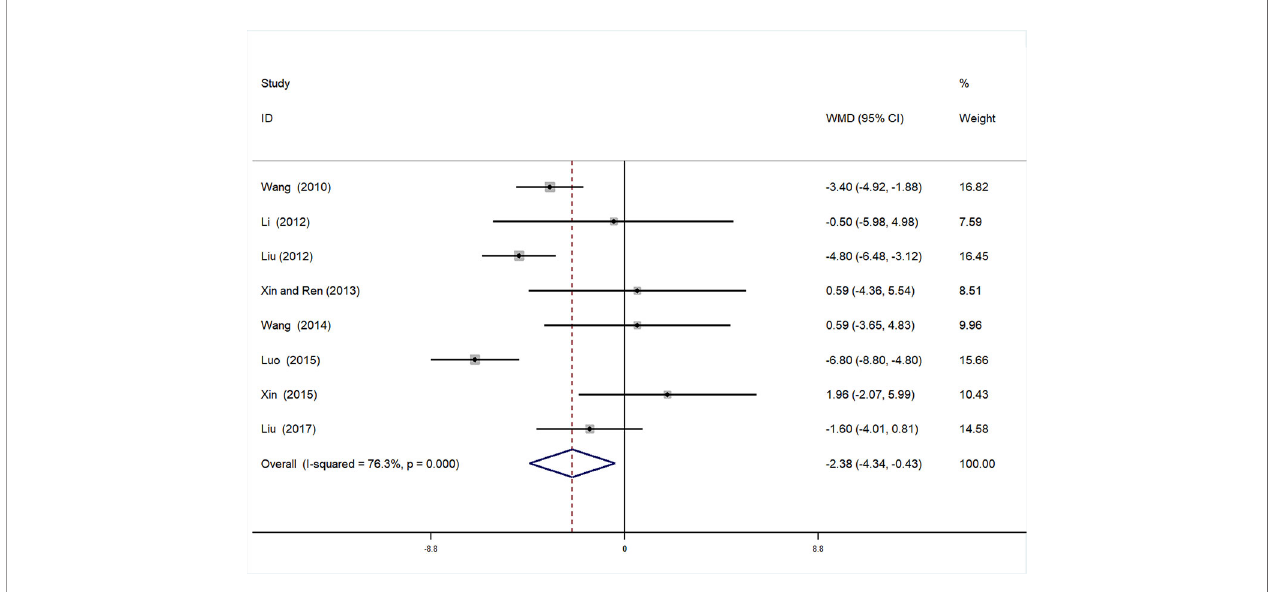
FIGURE 8 | Forrest plot of DBP.